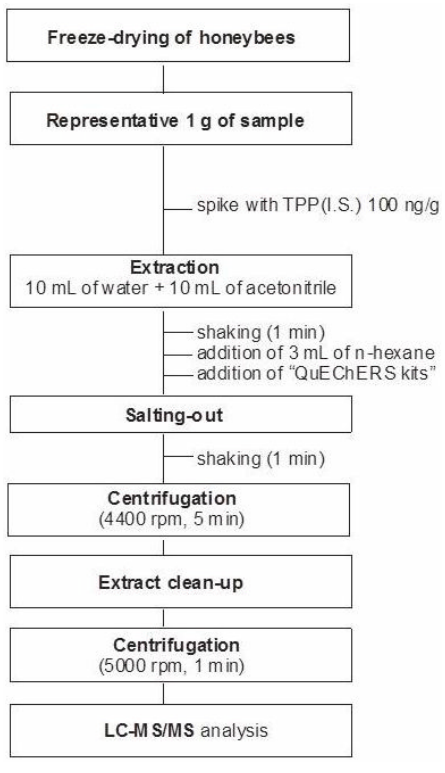
Figure 4. The procedure of modified QuECheRS/d-SPE sample work-up for the determination of pesticides in honeybee